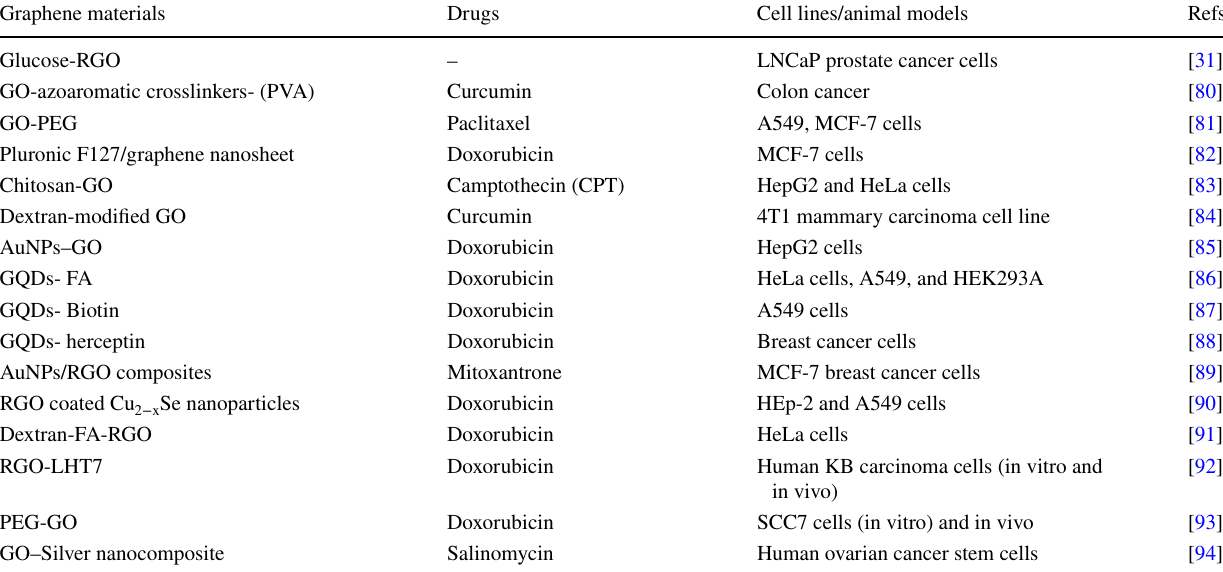
Table 1 Different graphene materials for cancer treatment (in vitro and in vivo studies)